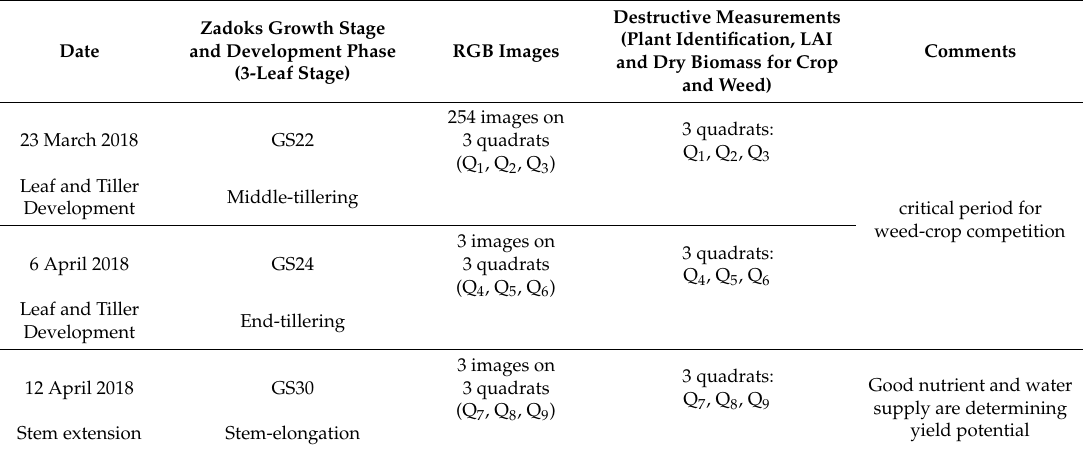
Table 1. Acquisition dates, image dataset and wheat growth stages.